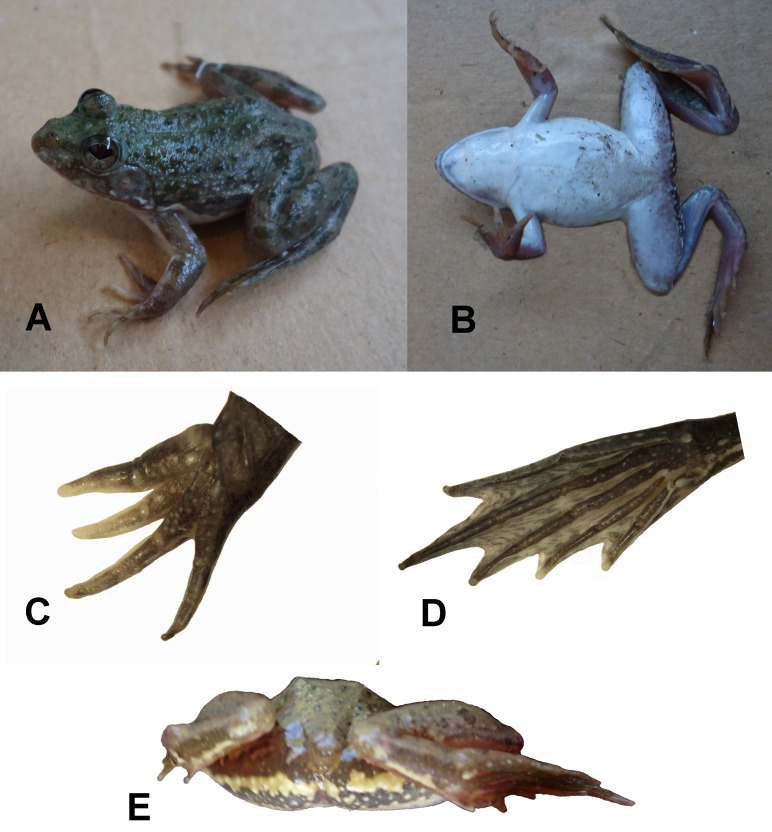
Photographs of Euphlyctis kalasgramensis sp. nov.(A) Dorso-lateral view of male (holotype) (B) Ventral view of male (holotype), (C) Ventral view of hand, (D) ventral view of foot, and (E) posterior view of thighs.